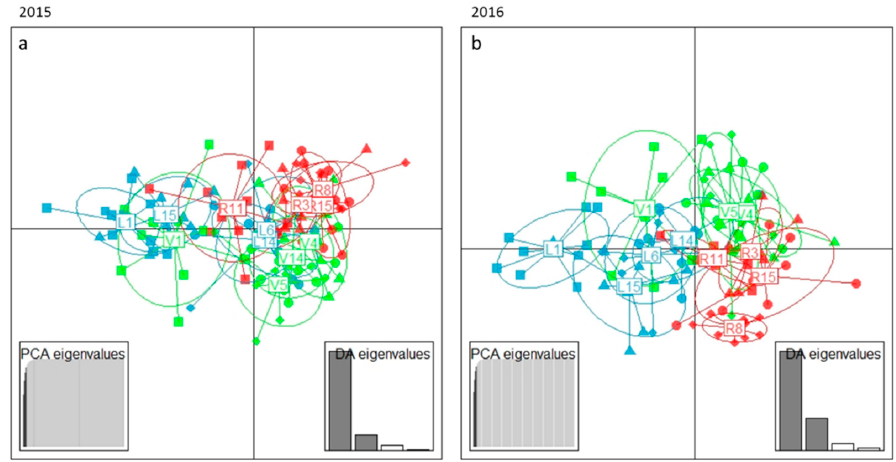
Figure 4. Data representing the variation among the genotypes by applying the discriminant analysis of principal components (DAPC) method ( a ) 2015 based on leaf spectral reflectance ( n = 9–11) replicates for genotype) ( b ) 2016 based on leaf reflectance ( n = 3 × 3) replicates for genotype). Each point corresponds to a leaf sample and is colored according to the provenance (Loppi (L, 60° N,